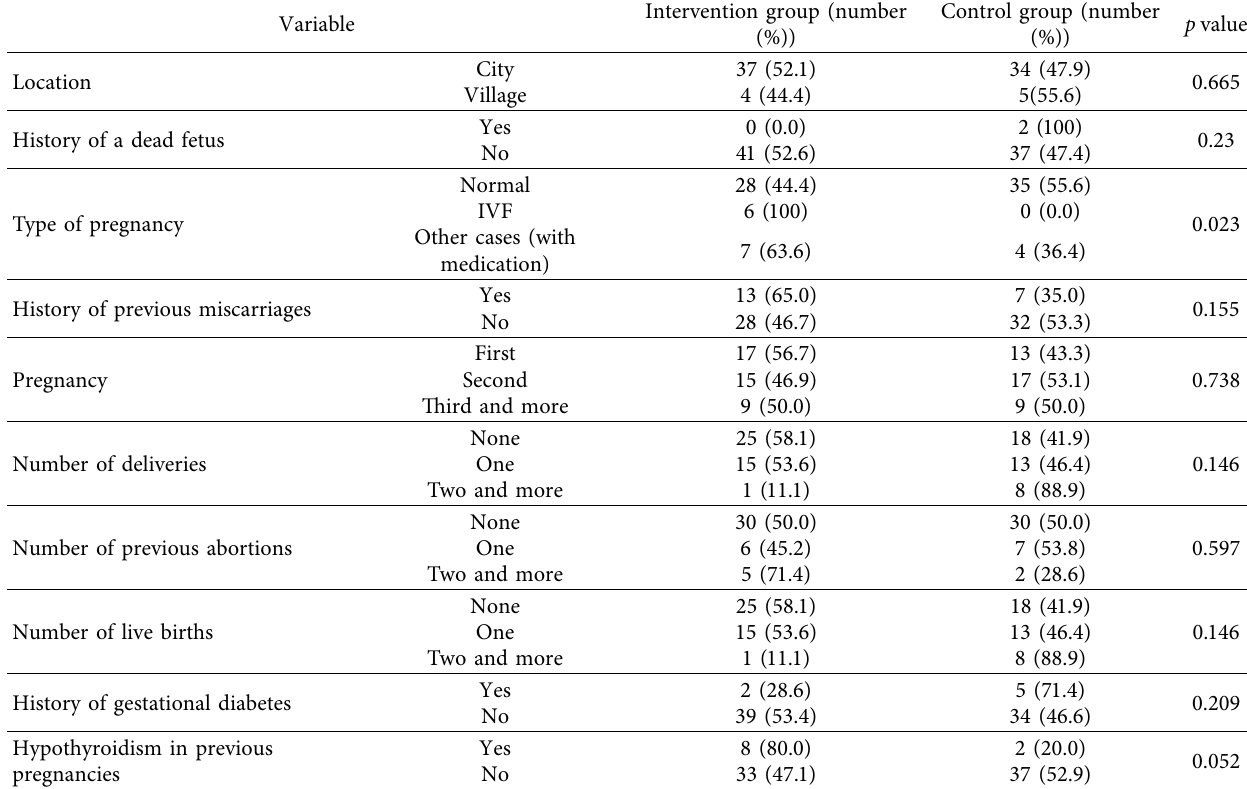
Table 1: Comparison of the frequency distribution of baseline qualitative characteristics between the intervention and control groups.